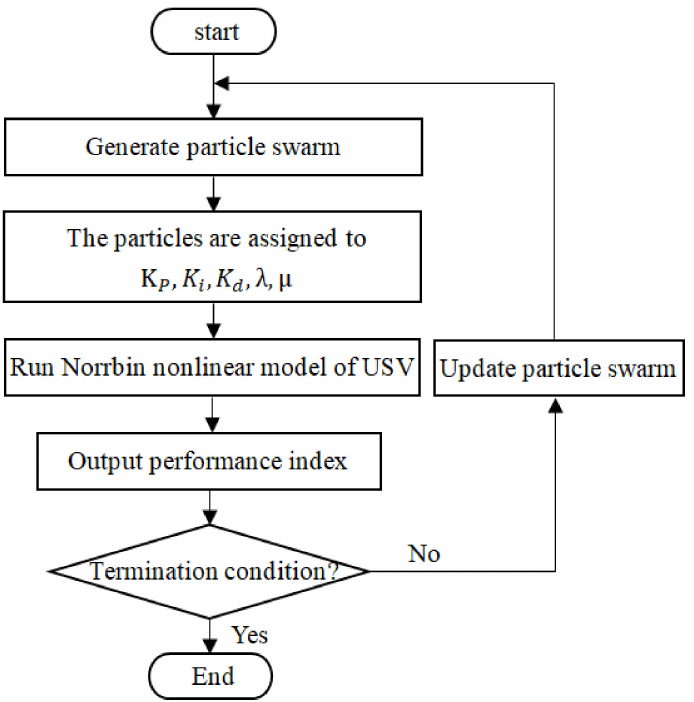
Figure 8. Process of IPSO optimizing the FO PI λ D µ